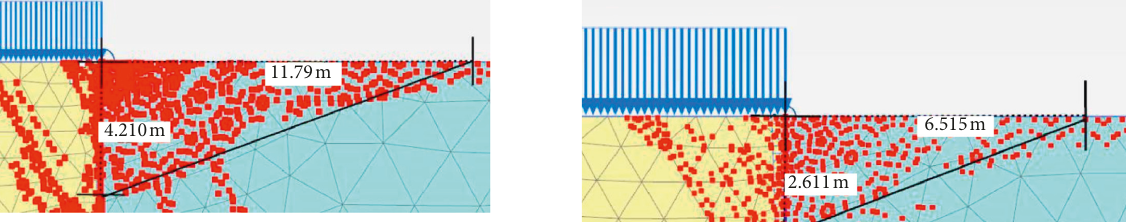
Figure 12: Distribution of failure points inside the foundation pit at φ � 20 ° .